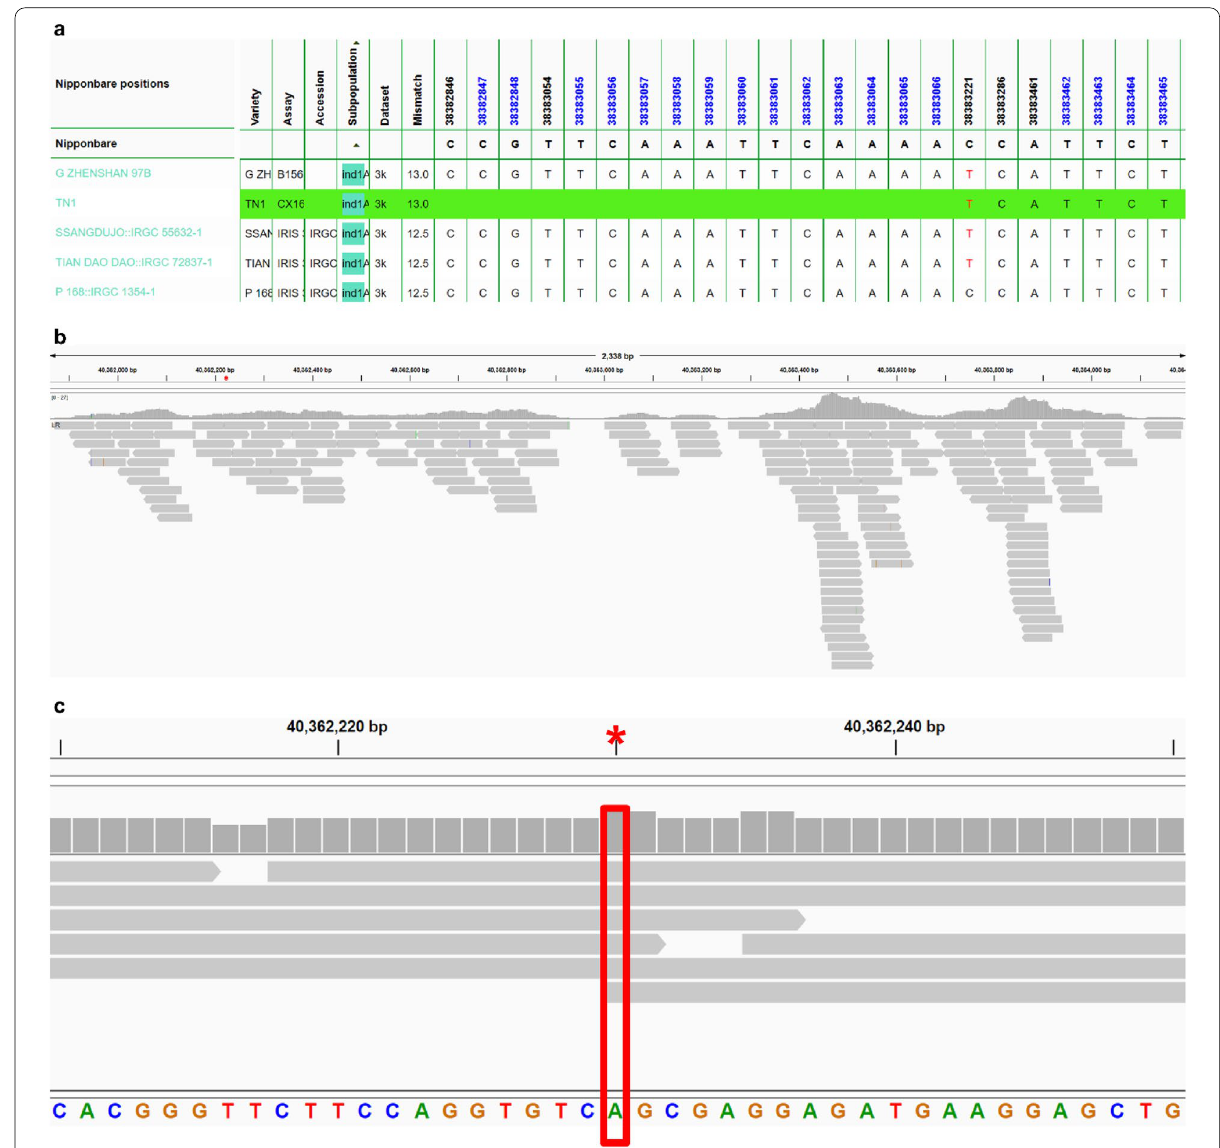
Fig. 3 sd1 gene SNP‑Seek result for TN1 and mapping of the CX162 reads. a Screenshot of the Genotype search result of the SNP‑Seek database for the sd1 gene. The blank green space for the TN1 cultivar assay CX162 signifies the absence of genomic DNA in TN1 with respect to the Nipponbare reference genome. According to the alignment in Fig. 1, the deleted region in Nipponbare sd1 lies in between 38,382,762 and 38,383,144 of chromosome 1 and is consistent with the missing TN1 SNPs in SNP‑Seek with respect to the Nipponbare reference genome starting at position 38,382,846 up to position 38,383,066. b Mapping coverage of the TN1 (assay CX162) 3 K RGP reads onto the sd1 gene region of the TN1 genome. The bam file was filtered to only get the properly paired reads with the proper distance. The gray color means that the read sequence is identical to the TN1 genome. The red asterisk is the approximate location of the start of the sd1 deletion with respect to the Nipponbare genome. c Closeup of the asterisk area in Fig. 4b. It has the coordinate 40,362,230 in TN1 chromosome 1. It corresponds to the extra nucleotide that made the sd1 deletion in TN1 and IR8 382‑bp, instead of 383‑bp. It is covered by 6 properly mapped paired‑end reads with the correct distance. Gray color means the read sequence are homozygous to the TN1